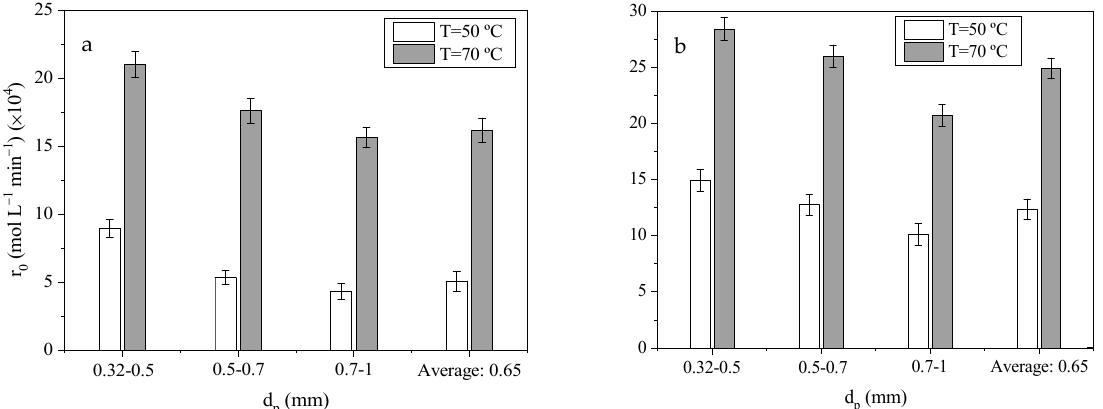
Figure 8. Internal mass transfer in the esterification of ibuprofen in reactive L-L-S triphasic systems without ( a ) and with added water ( b ) at zero time: initial observed reaction rate vs. particle diameter for 50 °C (white) and 70 °C (grey). Other operational conditions: C I0 = 60 g·L − 1 , C E = 30 g·L − 1 , N = 720 rpm.